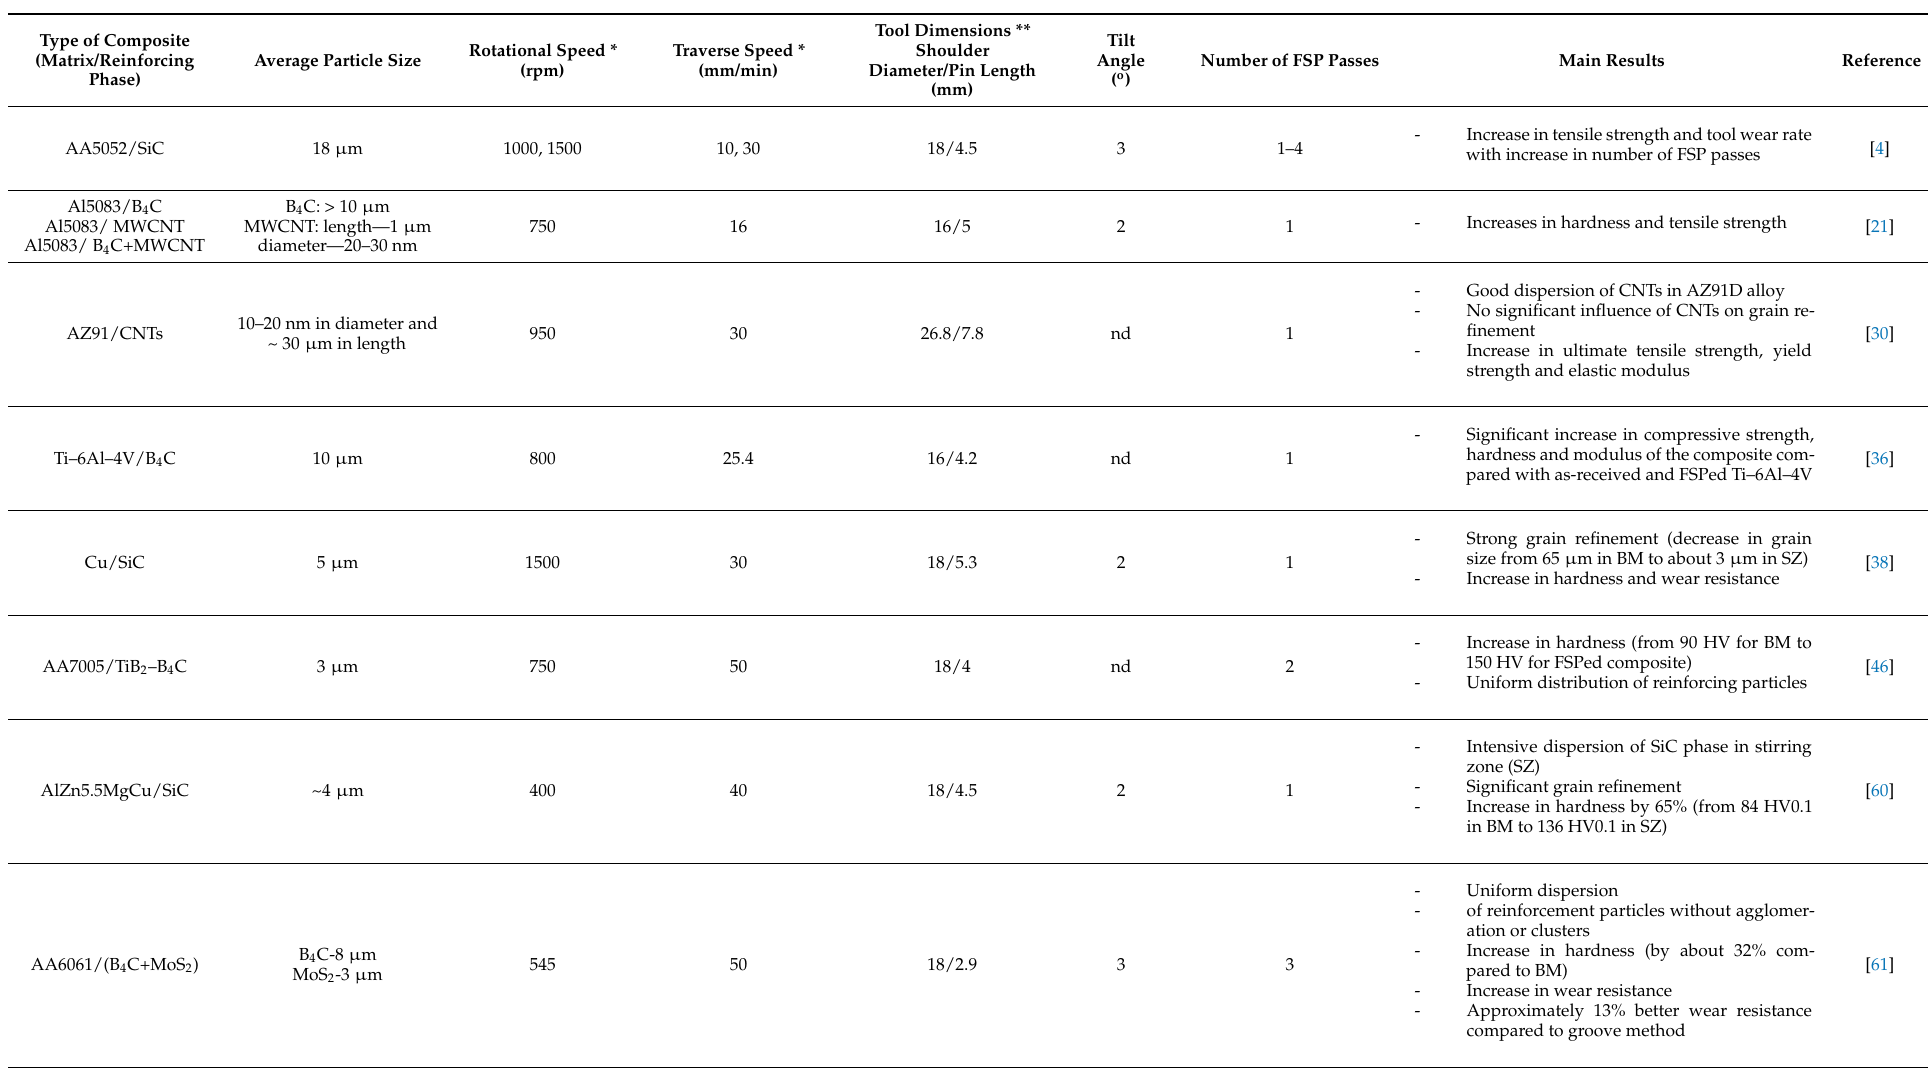
Table 2. List of cited